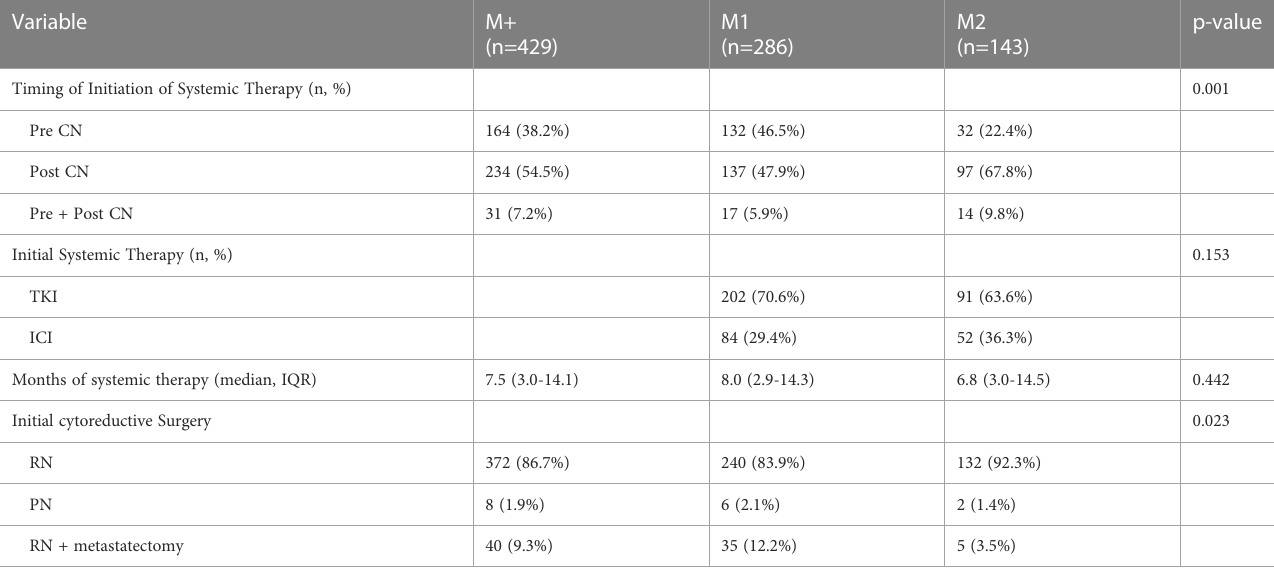
Timing of Initiation of Systemic Therapy (n,